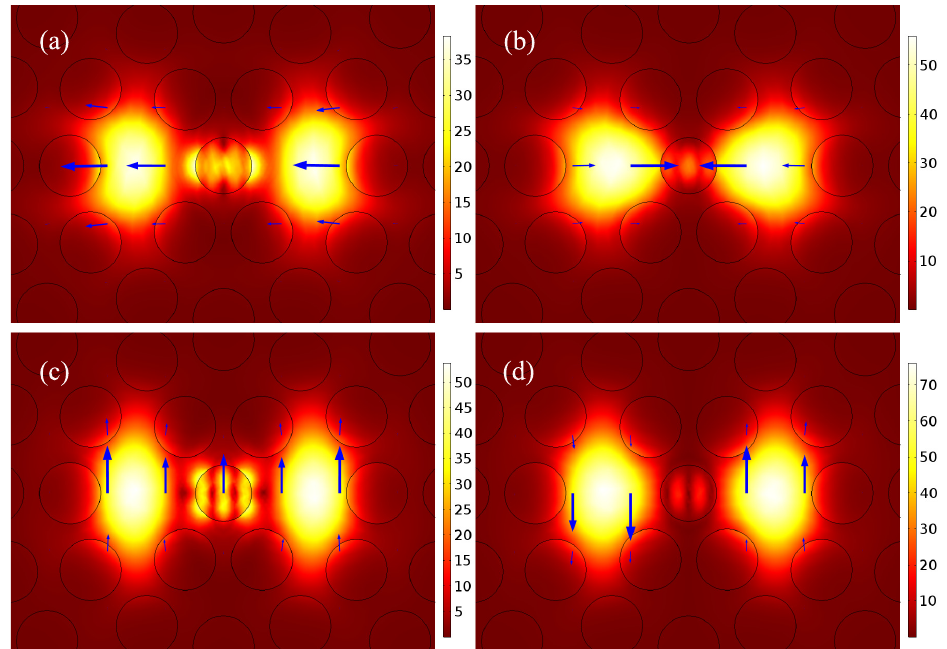
Figure 3. Electric field distribution of four supermodes in a circular double-core PCF beam splitter: ( a ) the x-polarized even mode ( b ) the x-polarized odd mode ( c ) the y-polarized even mode ( d ) the y-polarized odd